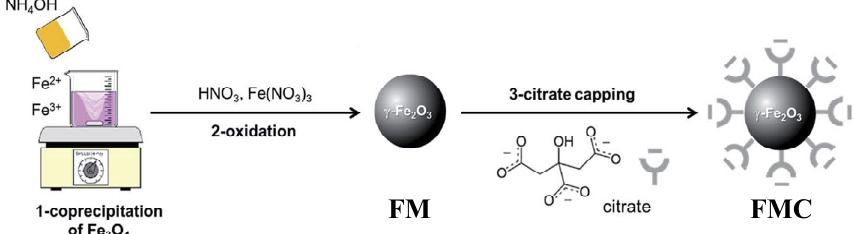
Figure 42. Scheme of the preparation of γ ‑Fe 2 O 3 nanoparticles (FM) with further surface function‑ alization with citrate (FMC). Adapted from Ref. [76] with permission from Springer Nature: Hy‑ perfine Interactions, “Effect of iron oxide nanoparticles functionalization by citrate analyzed using Mössbauer spectroscopy”, Ushakov M.V., Sousa M.H., Morais P.C., Kuzmann E., Semionkin V.A., Oshtrakh M.I., ©2020.